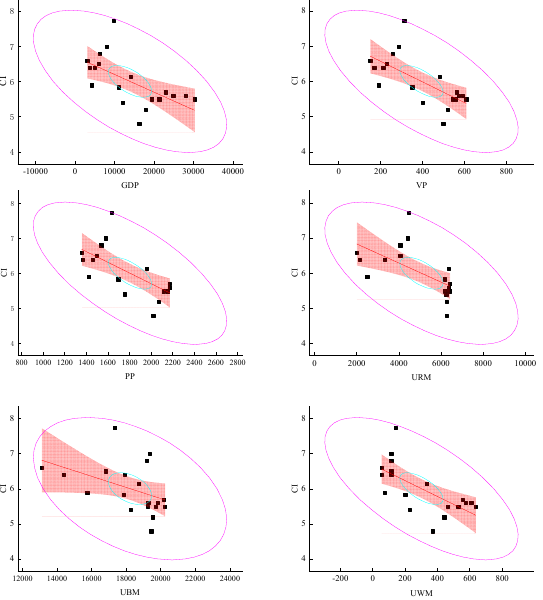
Figure 1. The pairwise plot between CI and socioeconomic factors.